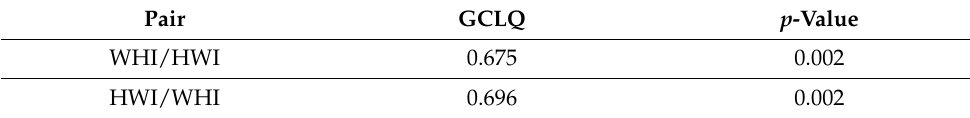
Table 2. GCLQ results for WHI and HWI point categories.